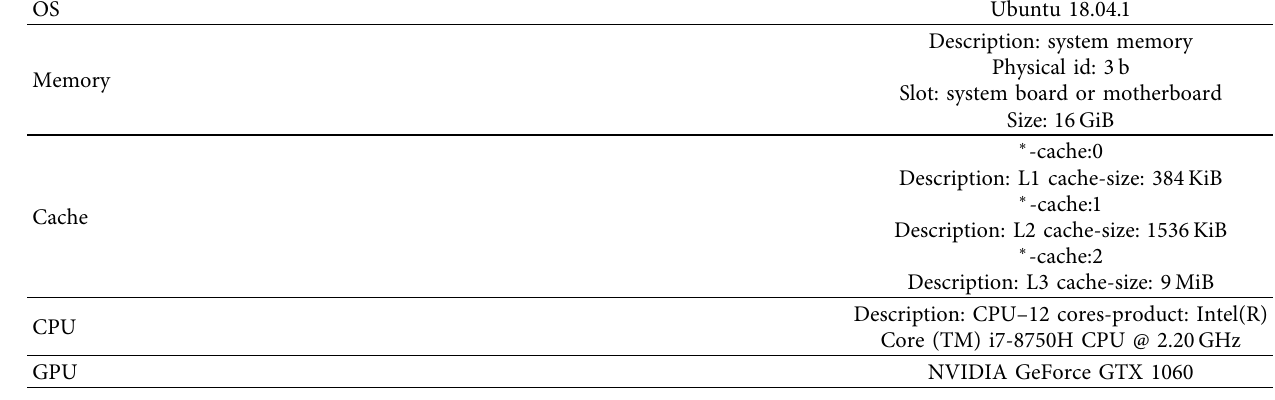
Table 1: System specification.